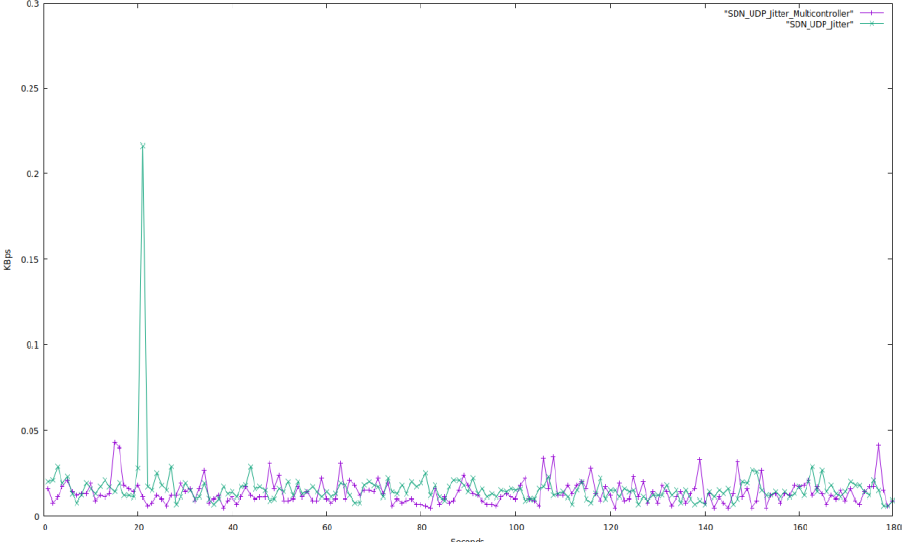
Figure 16. Jitter fluctuation single-controller SDN vs. Multi-controller SDN.